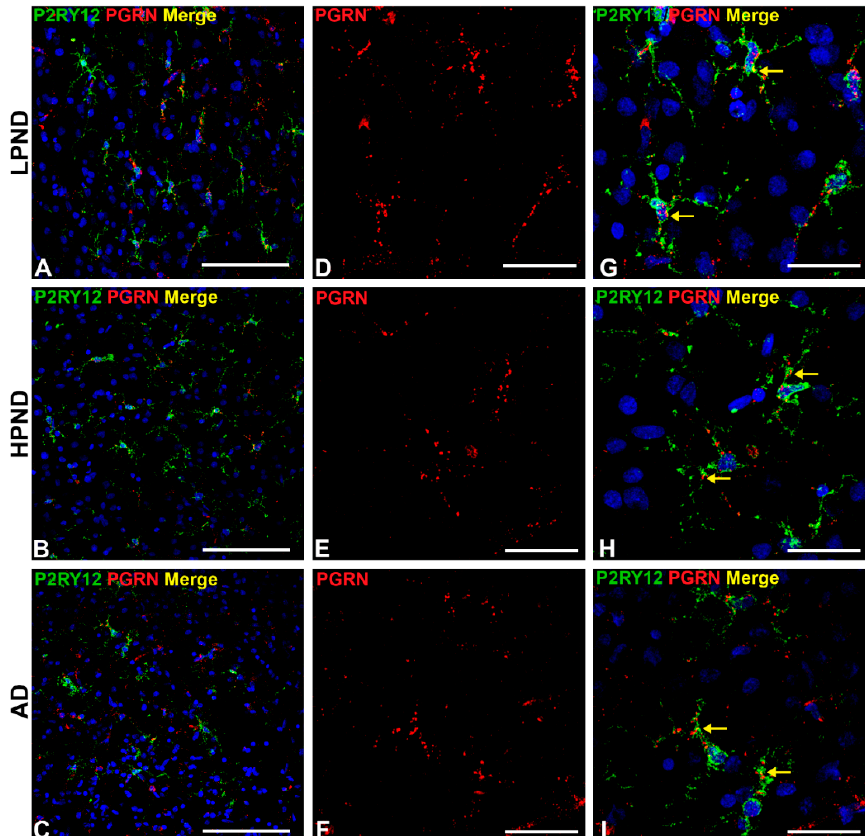
Figure 8. Confocal microscopy of P2RY12 and progranulin-positive microglia in pathologically